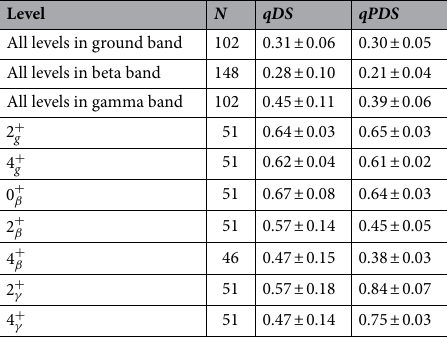
the different energy levels by using the h 0 coefficients, which varied in the specific interval with Δ h 0 = 0.5 keV step changes while the h 2 assumed to be 5.89 keV, the averaged value of this quantity for the considered nuclei. We then repeat this process by using different h 2 values, which varied in their interval with Δ h 2 = 0.5 keV step changes and assumed h 0 = 6.45 keV. Results are presented in Fig. 1a,b for the variation of h 0 and h 2 , respectively. PDS results show the same tendency in the spectral statistics of different levels and suggest the more chaotic behavior in all sets of h 0 and h 2 coefficients, similar to what has been reported using the experimental data. Additionally, more GOE-like behaviors are yield via the maximum value of h 0 and minimum values of h 2 . One may conclude the correlation of the levels is the result of the pairing effect on the energy spectra while, the Poisson-like behavior in the spectral statistics yield, is due to the quadrupole interaction.